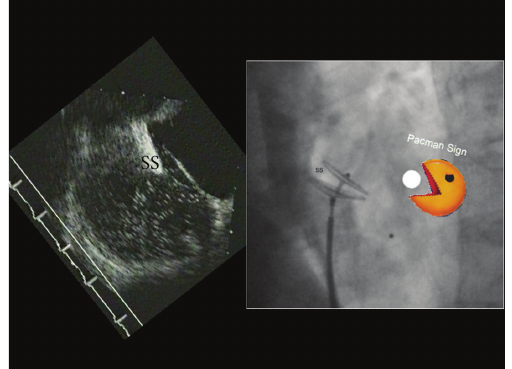
Figure 3: Correct placement of an Amplatzer PFO occluder ascer- tained by the Pacman sign. The transesophageal echocardiogram at the left is depicted in the projection usually used on fluoroscopy during implantation. The septum secundum (SS) has to be bitten into by the left more cranial parts of the occluder disks. This reminds us of Pacman biting into a dot.